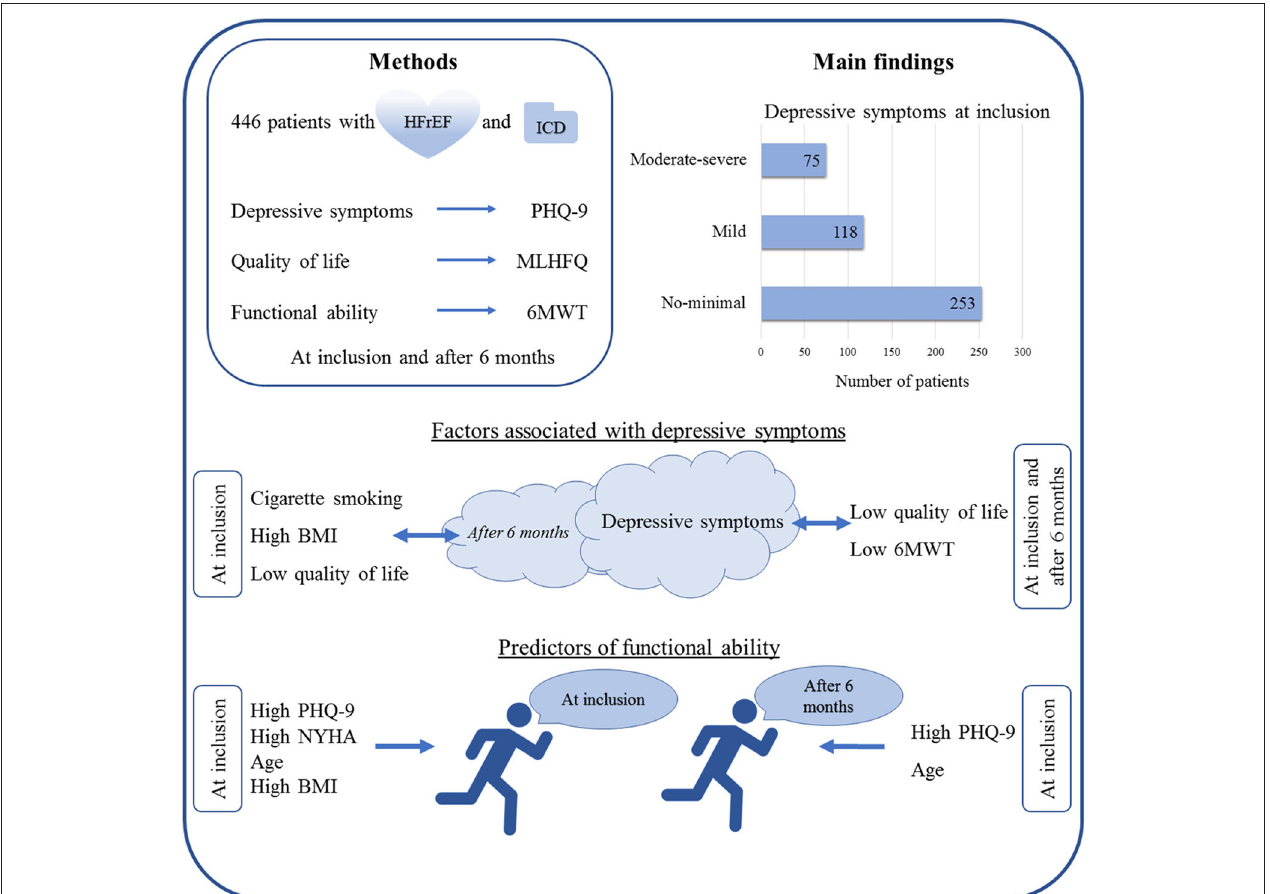
FIGURE 1 | Summary figure. Overview of the methodology and main results of the present study.